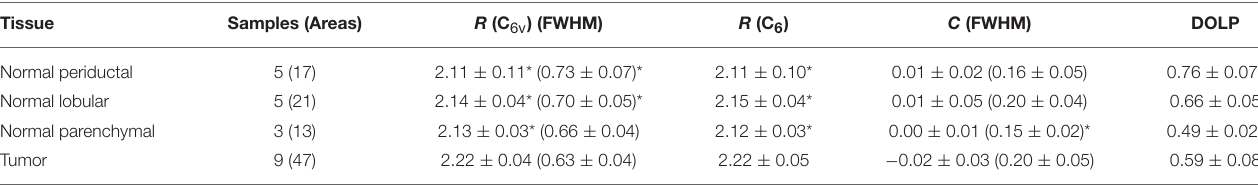
TABLE 1 | R, C, and corresponding DOLP values (mean ± standard deviation) assuming C 6v symmetry and C 6 symmetry.